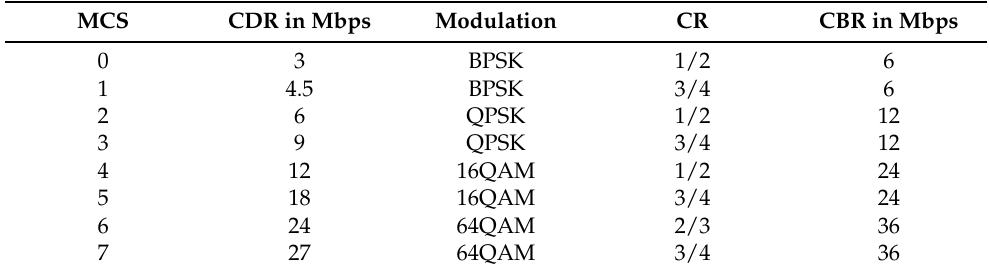
Table 1. MCS values with associated coded data rate (CDR), modulation, code rate (CR), and coded bit rate (CBR) for the IEEE 802.11p OFDM PHY layer at a bandwidth of 10MHz, which represents the used action space for each of the following experiments